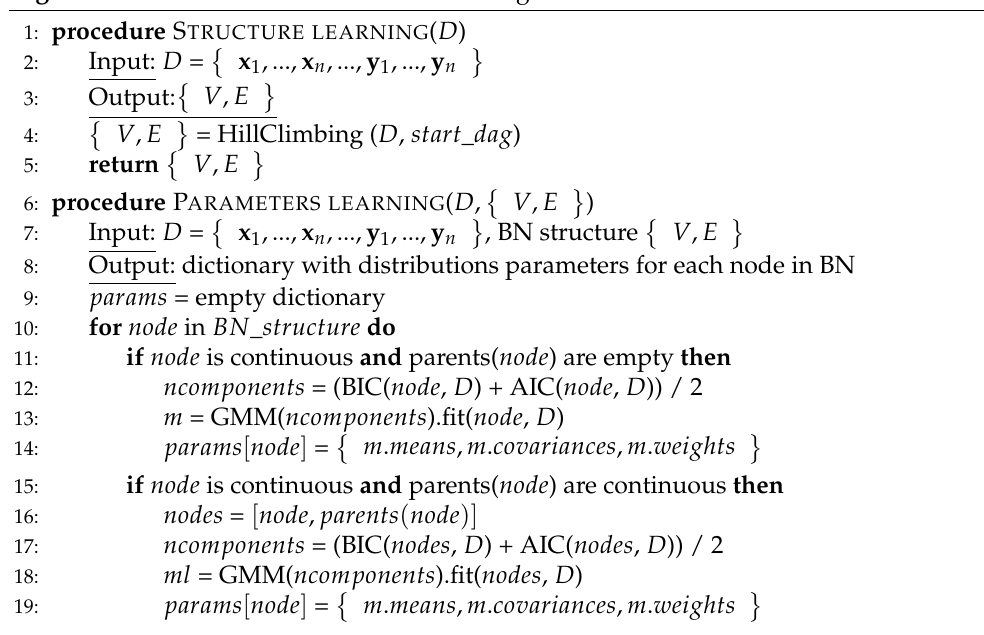
Figure 2. An example of GMR for a two-dimensional mixture with three components. Algorithm 1 Structure and Parameters learning for continuous nodes in BNs with